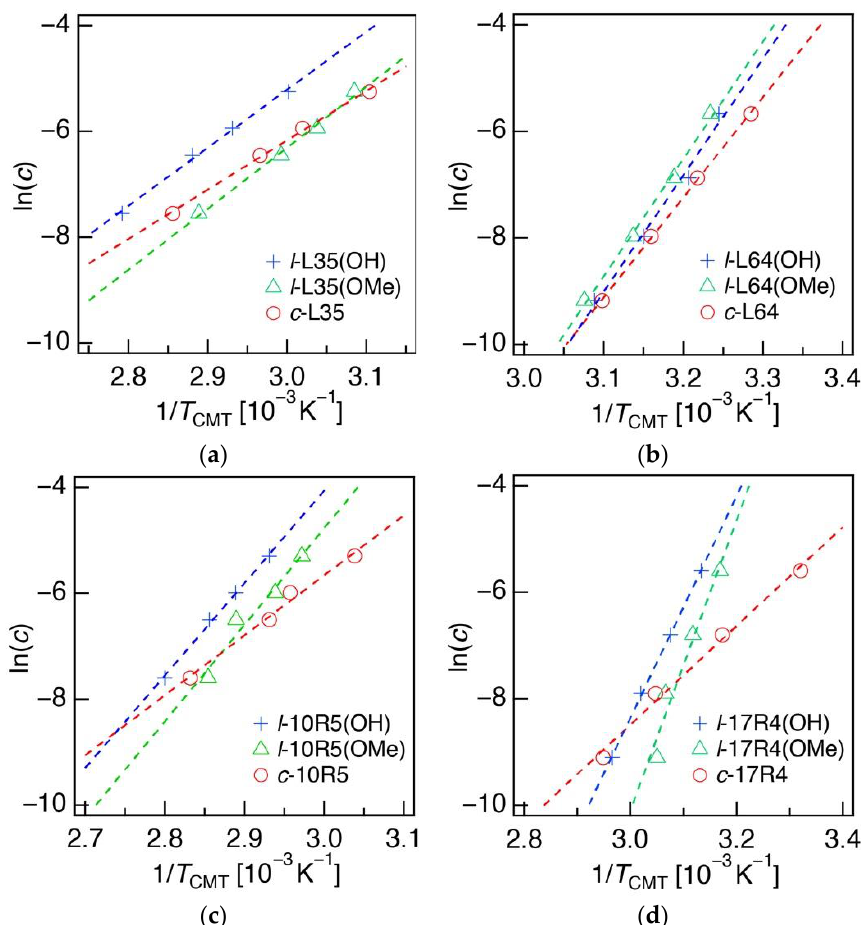
Figure 2. ( a ) ln( c ) vs. 1/ T CMT plot for aqueous solutions of linear hydroxy-terminated (blue), meth- oxy-terminated (green), and cyclized (red) L35, indicated as l -L35(OH) , l -L35(OMe), and c -L35 , re- spectively. Those of ( b ) L64, ( c ) 10R5, and ( d ) 17R4 are also shown. Enthalpy of micelliza tion (Δ H mic ) was calculated from the slope of the linear fitting of the plots.